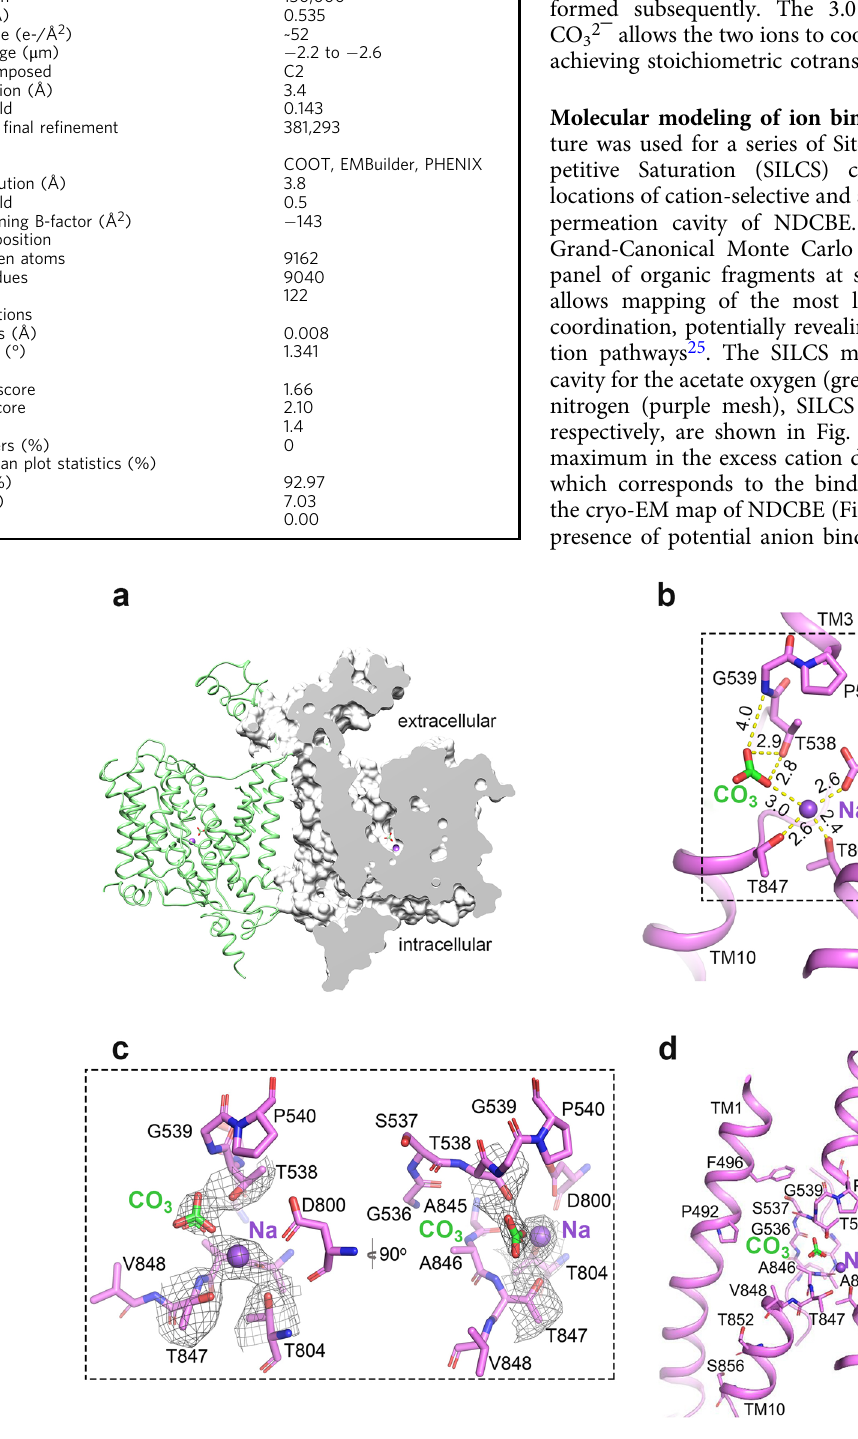
Fig. 2 Two ion binding sites in OF NDCBE. a An NDCBE monomer model presented as a surface (right) showing an extracellular-facing cavity. b The Na + and CO 3 2 ‾ ions are coordinated at TM3, TM10 and TM8. Numbers show distances in Å between the ions and NDCBE coordinating atoms. c Magni fi ed views of the Na + and CO 3 2 ‾ binding sites in NDCBE. All cryo-EM densities are shown at the same contour level of 0.02 σ . d Mapping of residues whose mutations signi fi cantly reduce NDCBE transport activity in and near the ion coordination area. Na + and CO 3 2 ‾ are shown as a purple sphere and green- red sticks, respectively.